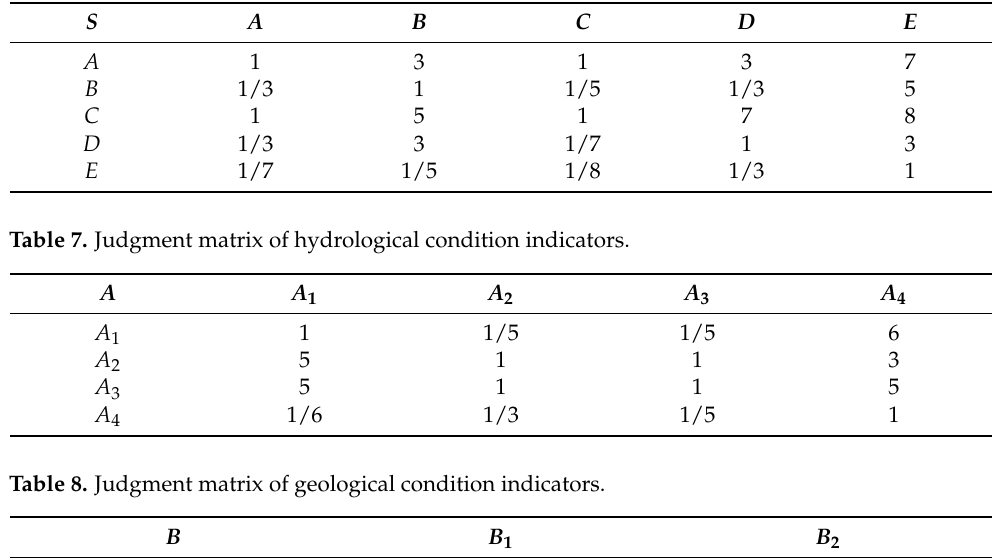
Table 6. S-A judgment matrix.